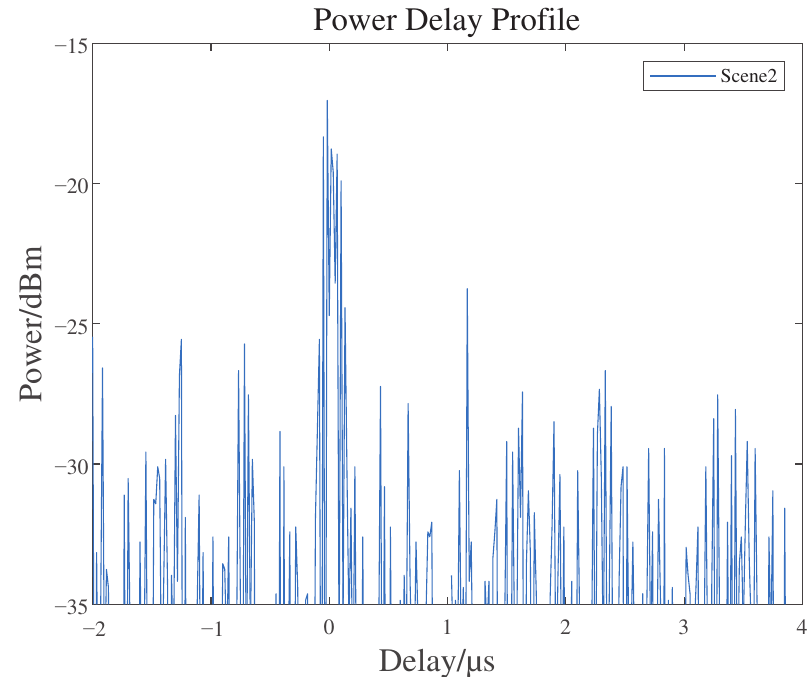
Figure 10. Channel sounding PDP of scene